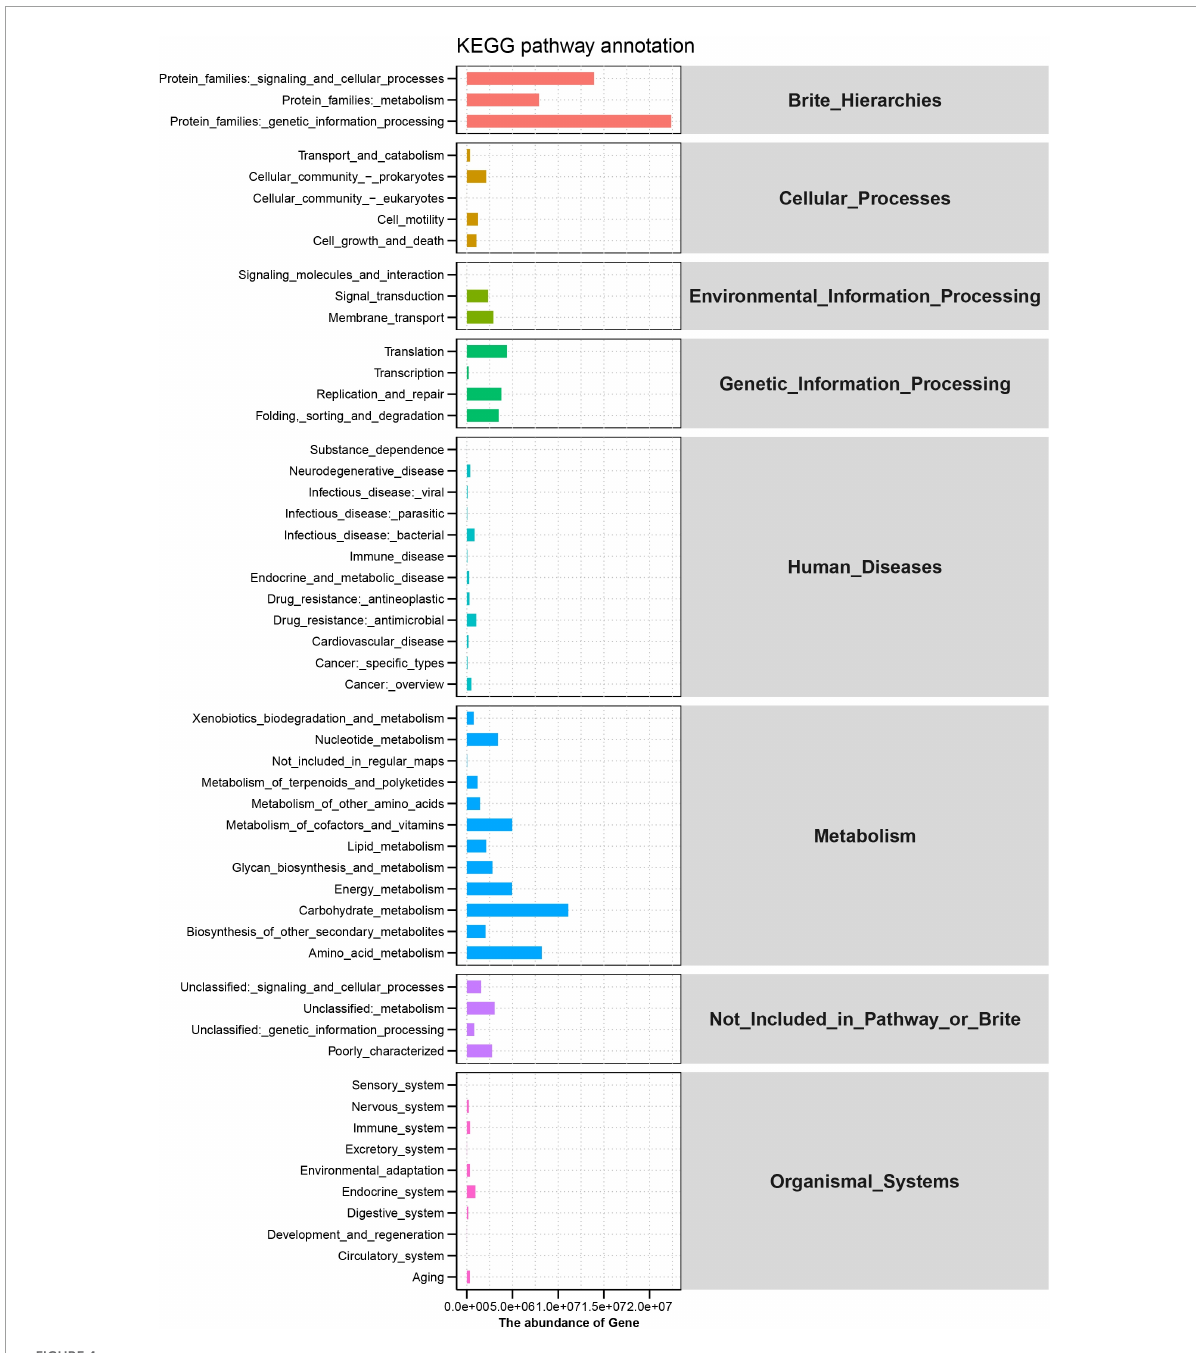
FIGURE4 Predicted microbiome function and Kyoto Encyclopedia of Genes (KEGG) pathways in the rumen of Hu